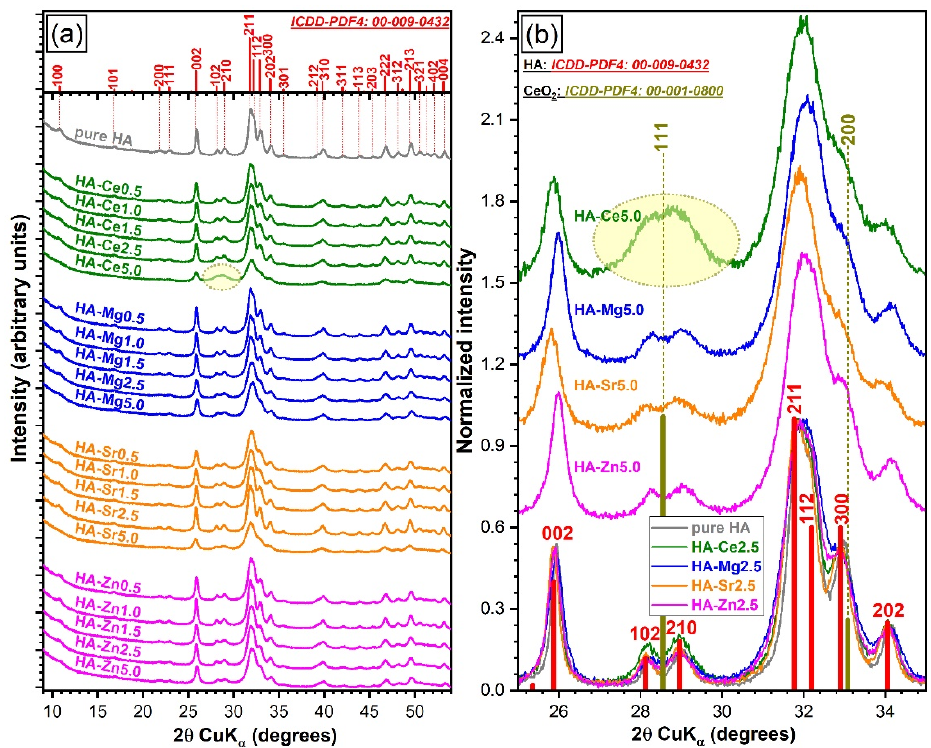
Figure 6. ( a ) X-ray diffraction patterns of all pure and substituted HAs (0.5 to 5 at.%). ( b ) Comparison of XRD patterns for HAs with substituent concentrations of 2.5 and 5 at.%, zoomed in the 2 θ angular region ≈ 24–35°. The reference diffraction files of hexagonal hydroxylapatite (ICDD: 00-009-0432) and/or cubic CeO 2 (ICDD: 00-001-0800) are represented as bars.